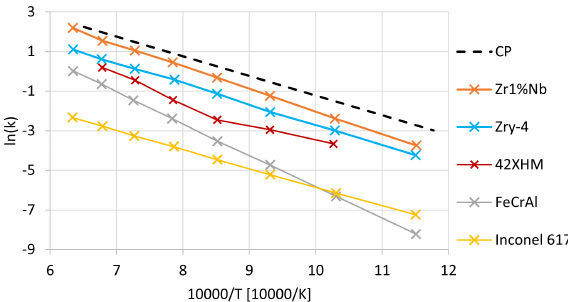
Figure 12. Arrhenius-plot of the estimated oxida- tion rate constants for various alloys, i.e. Zr1%Nb, Zircaloy-4, Cr-Ni, FeCrAl in steam